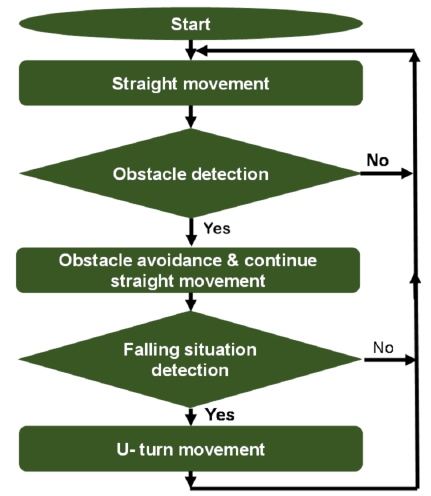
Figure 3. Flowchart of the robot’s movement generation.